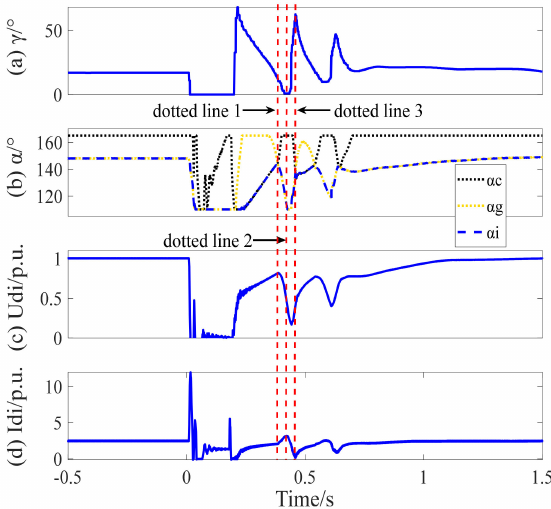
Figure 7. Simulation results of the DC control system. ( a ) Extinction angle, ( b ) Outputs of inverter controllers, ( c ) DC voltage, and ( d ) DC